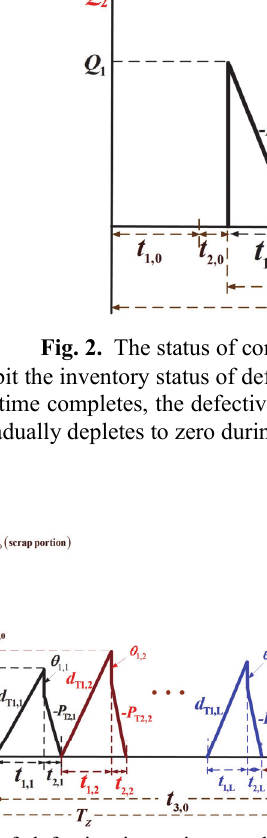
Fig. 4. The status of scraps in a replenishment cycle of our proposed